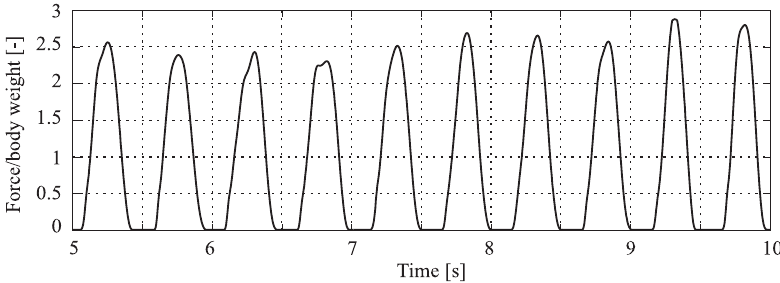
Fig. 4. Vertical force-time history due to a single person jumping.